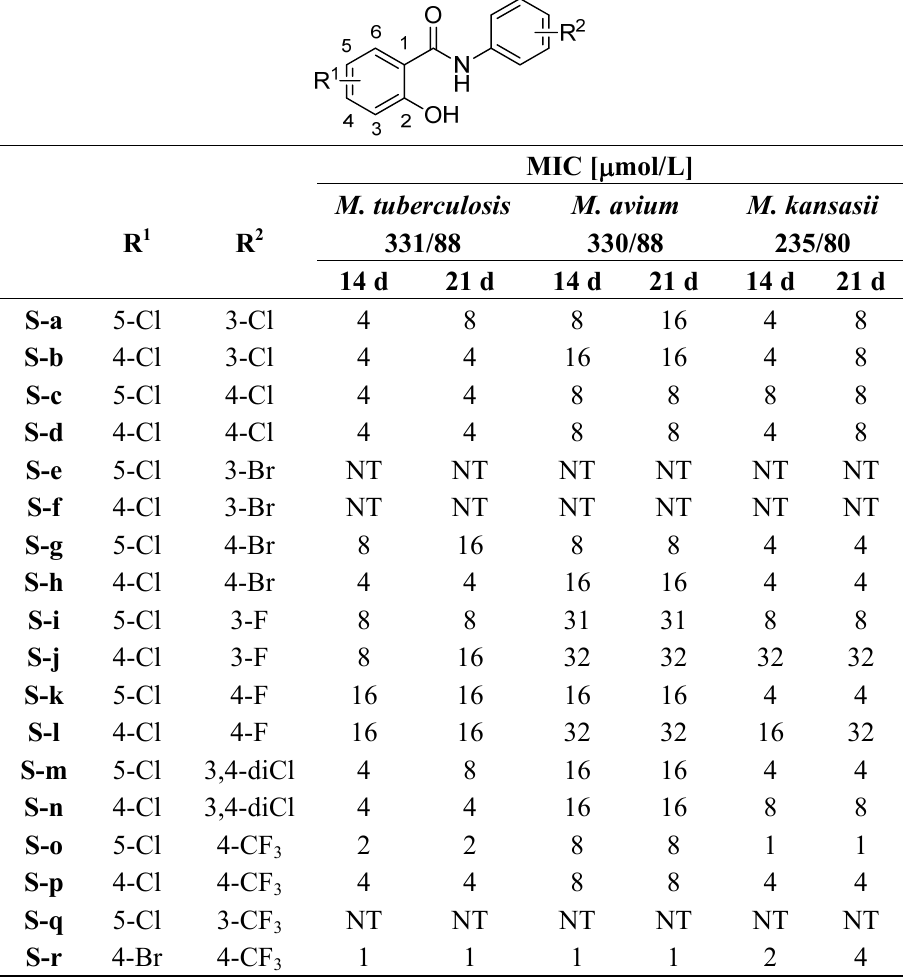
Table 2. Antimycobacterial activity of parent salicylanilides S